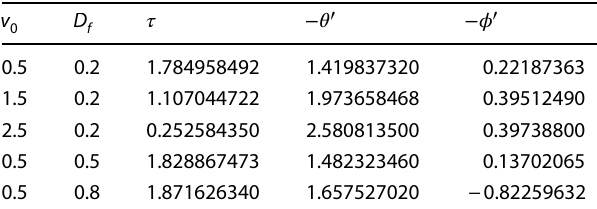
Table 1 Computed values for the local skin friction, rate of heat trans- fer, and rate of mass transfer for different values of v 0 and D f taking